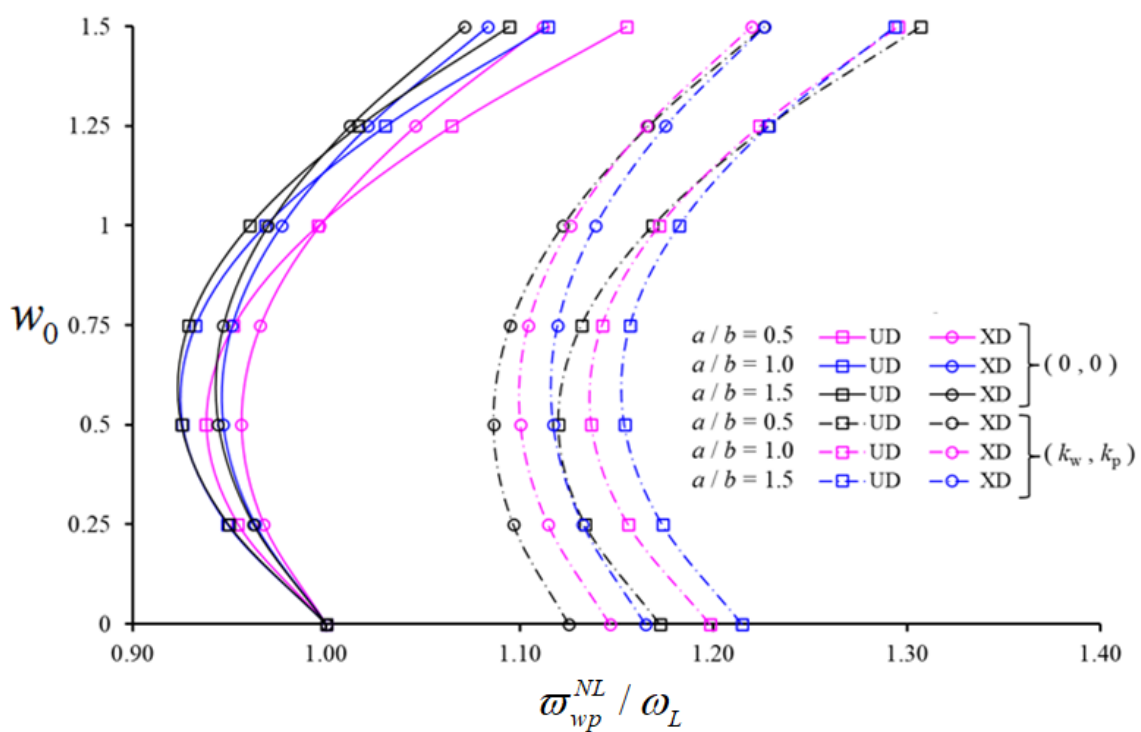
Figure 5. Variation in the NLFVF / LFVF ratio for shallow spherical shells containing UD- and XD-patterned CNTs in the presence/absence of a PF versus w 0 , with different values of a / b .